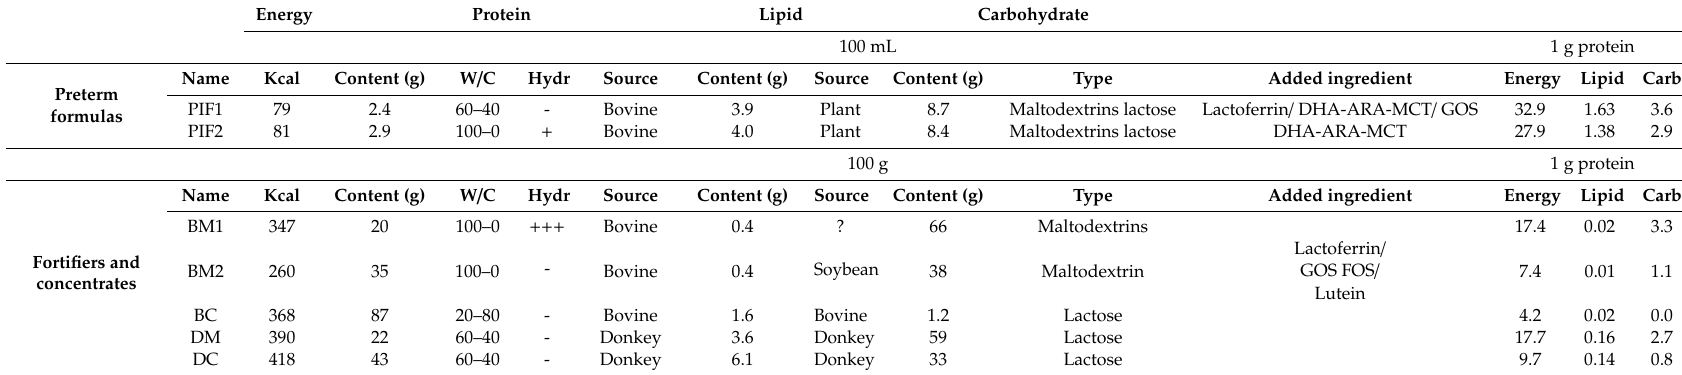
Table 1. Composition of commercial and experimental products used in the current study (source: manufacturers; “Latti formulati in commercio in Italia” by De Curtis M. and Gasparrini E.). Energy